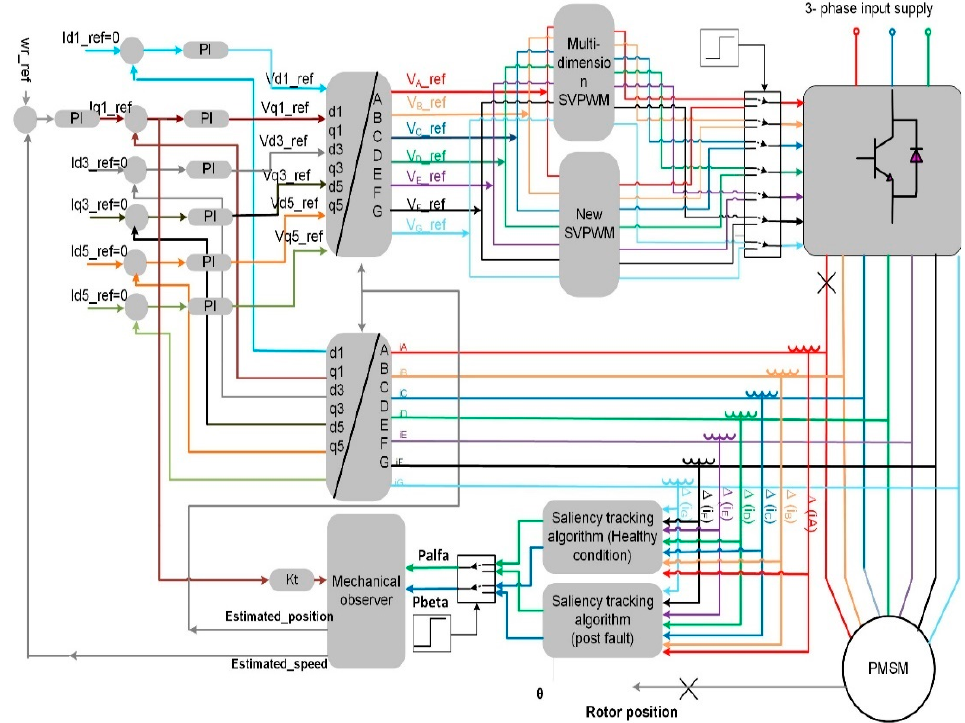
Figure 18. Speed control structure of the seven ‐ phase drive after the faults.